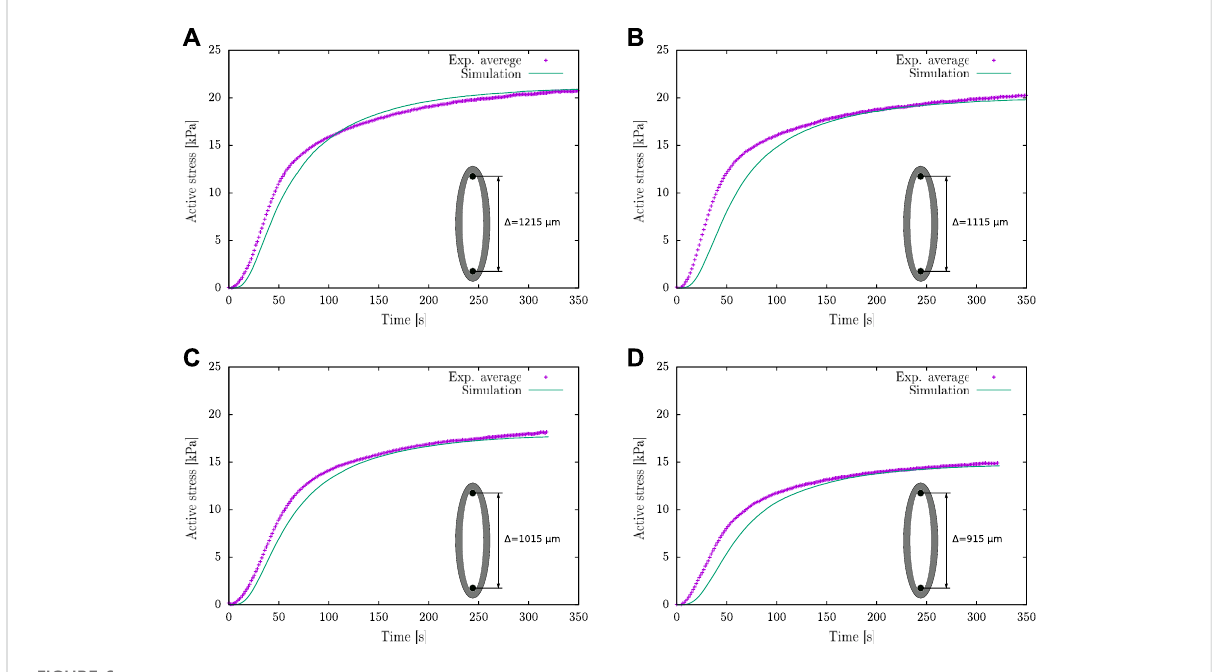
FIGURE 6 Activestressfordifferentwireseparationsintheisometriccontractiontest: (A) Δ = Δ opt =1,215 μ m, (B) Δ =1,115 μ m, (C) Δ =1,015 μ mand (D) Δ = 915 μ m.